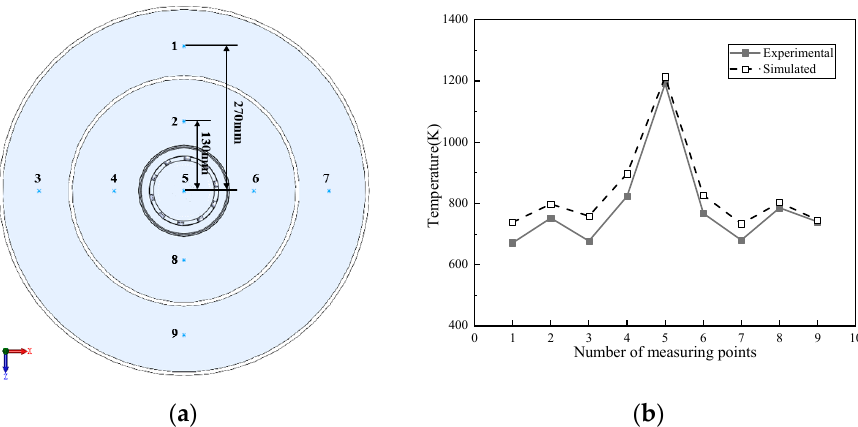
Figure 5. Validation of numerical methods: ( a ) measuring points setting; ( b ) comparison of experi- mental and simulated results.